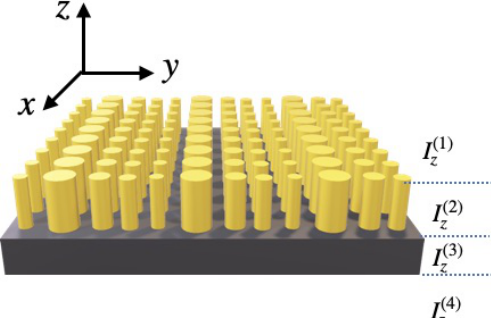
Figure 1. Sketch of a 2D grating. In the framework of the modal method, the 2 D structure is divided ( 1 ) ( 2 ) ( 3 ) ( 4 ) into 4 layers I z , I z , I z and I z with respect to the propagation direction that is assumed to be ( O , z )